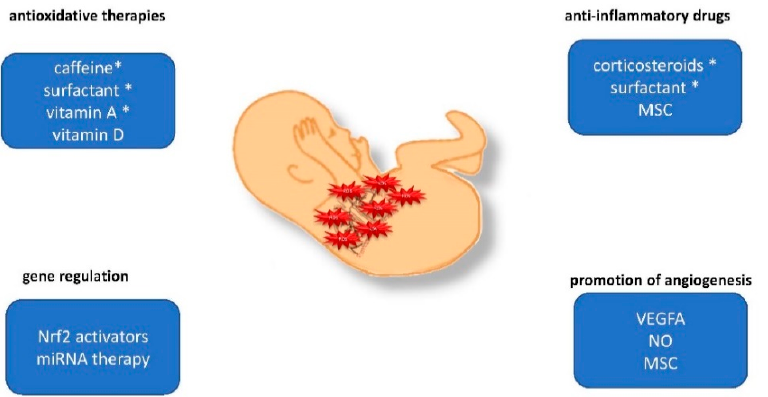
Figure 3. Therapeutic approaches to counteract the overexpression of ROS activity and its down- stream actions in the immature lung. Preclinical studies in rodents identified several highly promising strategies to counteract ROS production and the activation of downstream injurious actions in the immature lung. Strategies are categorized by their main documented or postulated mode of action. * Therapeutic approaches with proven efficacy in the preterm infant to prevent or treat BPD.